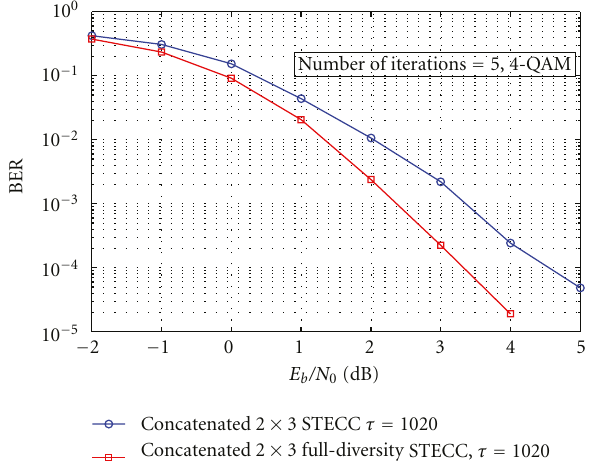
Figure 8: Performance comparison of the concatenated full diver- sity STECC and the concatenated suboptimal-diversity STECC. 3 × 4074 information bits. n r = 2. Outer code: the 2 / 3-rate punctured CC (133,171) . oct